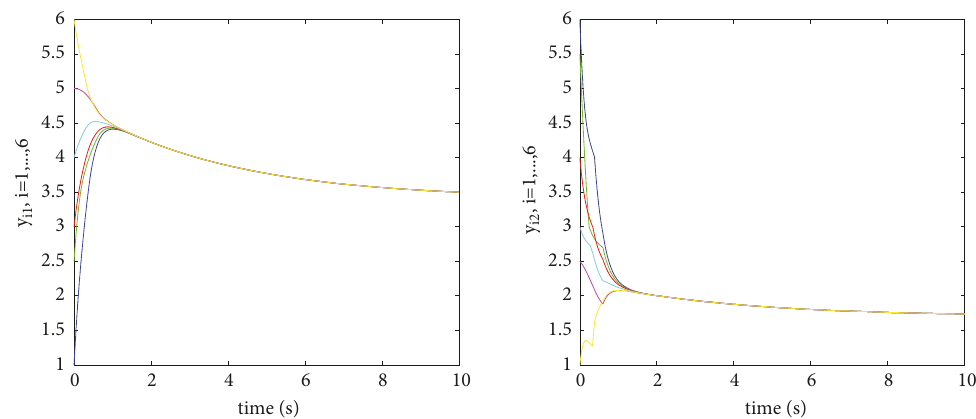
Figure 5: The state variables 𝑦(𝑡) under the node-based algorithm.